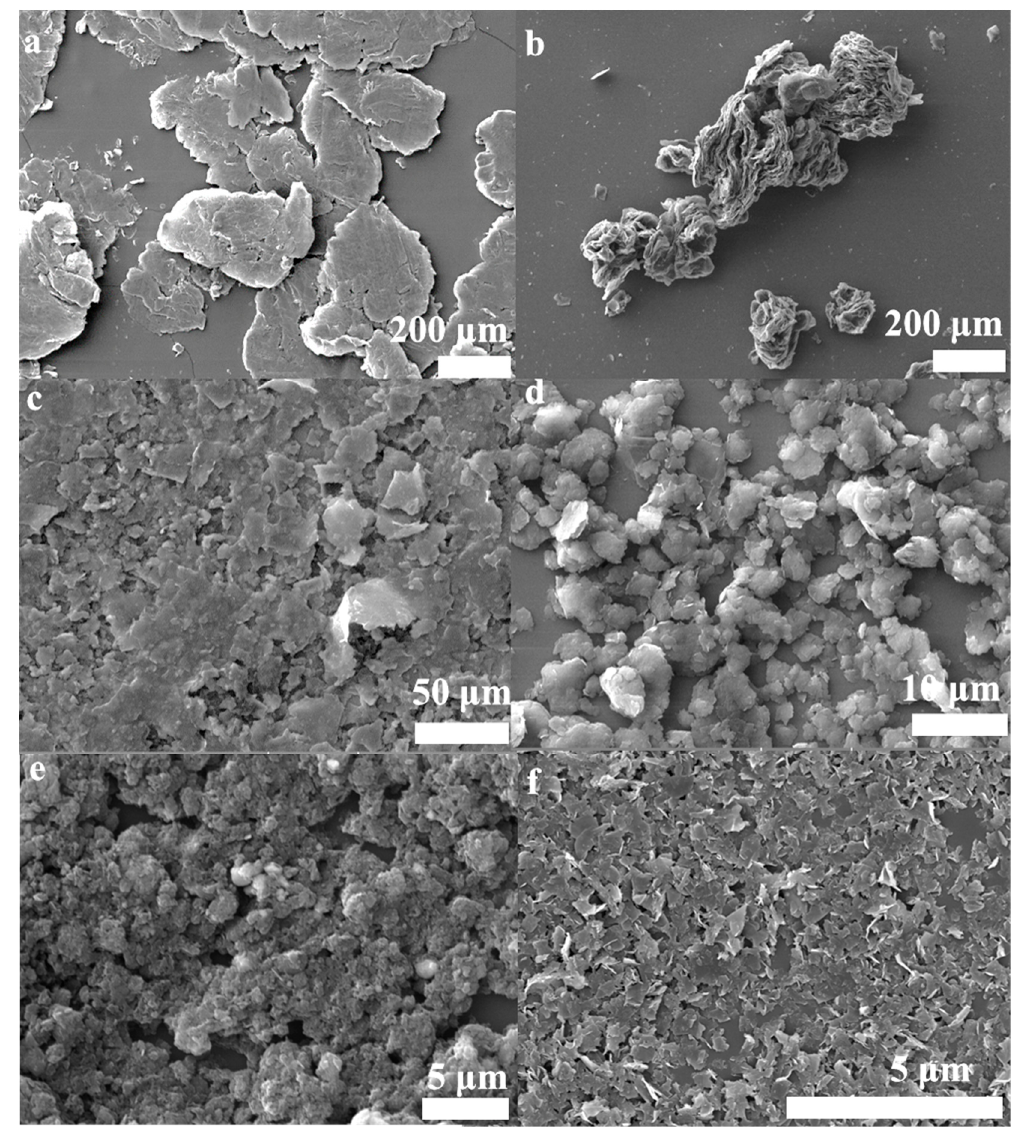
Figure 7. SEM images of the powders; ( a ) Expanded graphite, ( b ) the products were only obtained by hydrothermal treatment( OHPs), ( c ) the OBPs, ( d ) the BHPs, ( e ) the BFPs, ( f ) the FLG nanosheets.